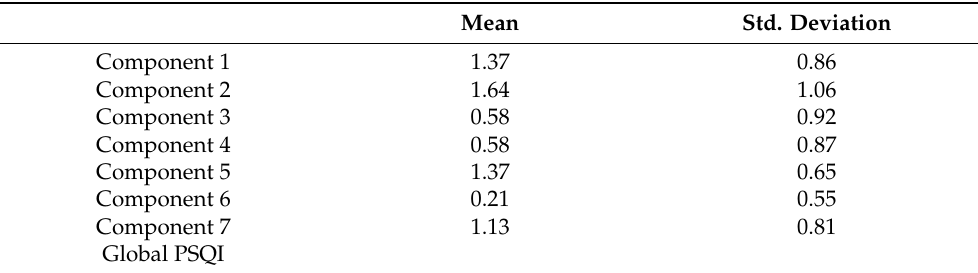
Table 9. Mean, standard deviation, and percentage deviation of PSQI. Mean Std. Deviation